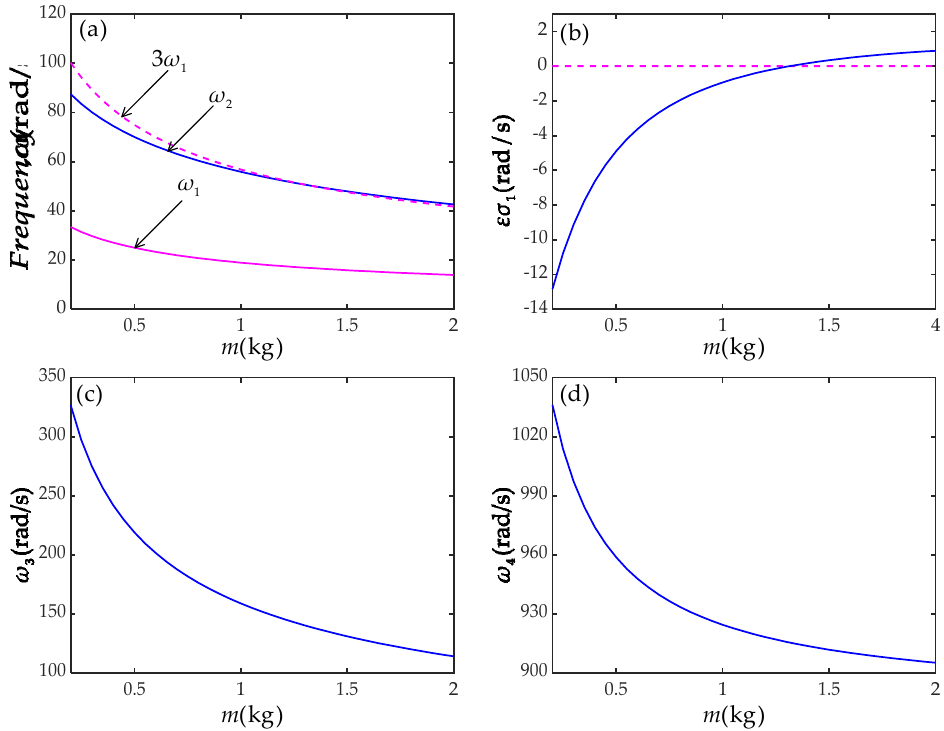
Figure 5. The first four natural frequencies versus tip mass m : ( a , b ): the relation between the first two natural frequencies, ( c ): the third natural frequency, ( d ): the fourth natural frequency. Table 2. Parameter values of the first two frequencies ω (rad/s) when m ≈ 1.32. σ = 0.01 Mode Shape Coefficient ω 1 = 16.79 ω 2 = 50.38 The first joint mode displacement Θ 1 j − 1.15 − 3.45 The second joint mode displacement Θ 2 j − 0.83 3.38 Tip mas horizontal mode displacement X m − 1.18 0.49 Tip mass vertical mode displacement Y m − 0.50 −